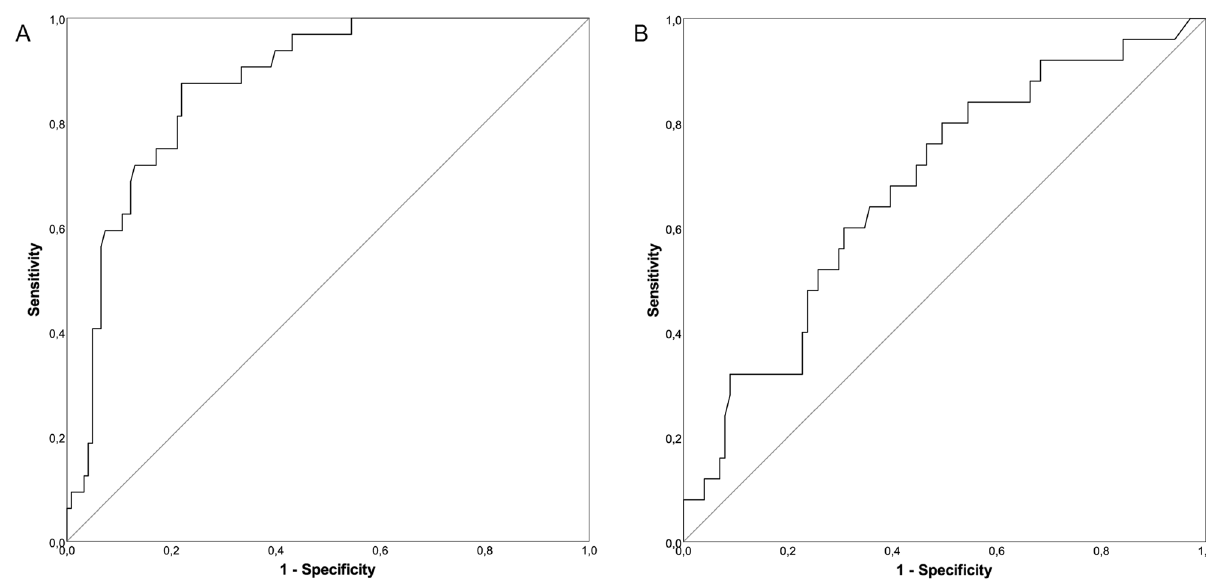
Figure 4. ROC curves of calprotectin levels in serum and saliva. Receiver Operating Characteristic curves to determine cut-off values of calprotectin levels in serum ( A ) and saliva ( B ) using the QUANTUM BLUE sCAL rapid test (black line: ROC curve; grey line: diagonal association